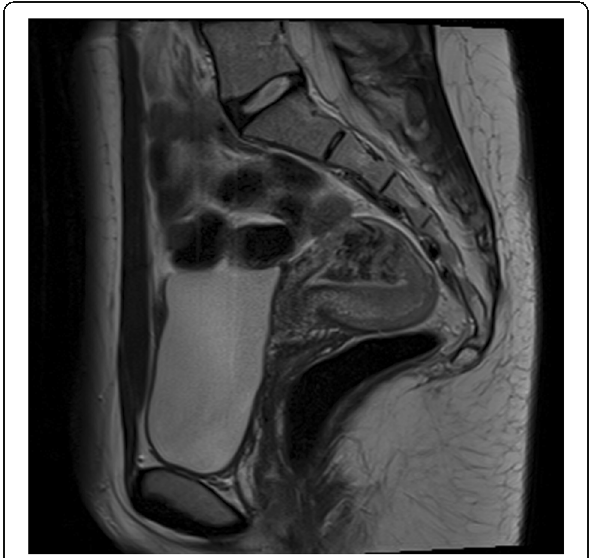
Fig. 6 Sagittal T2 weighted image demonstrates a serpiginous cluster of flow voids within the uterine